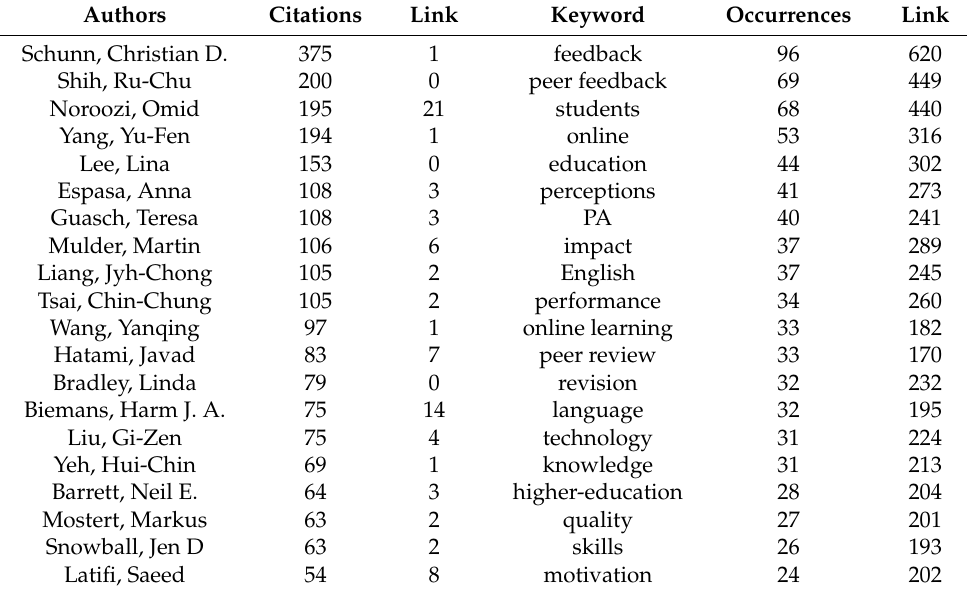
Table 4. The top 20 authors and keyword items in the search results.